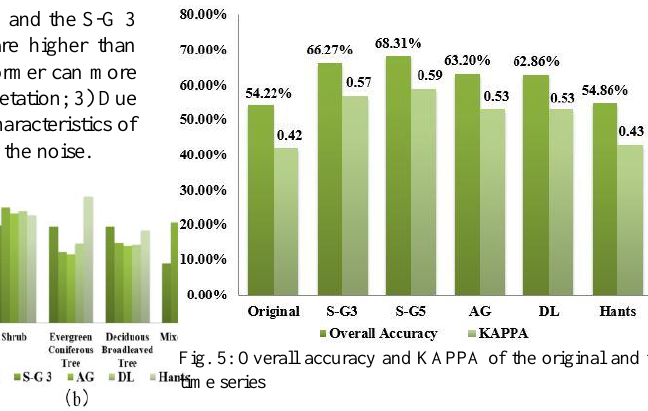
Fig. 5: Overall accuracy and KAPPA of the original and filtered NDVI time series